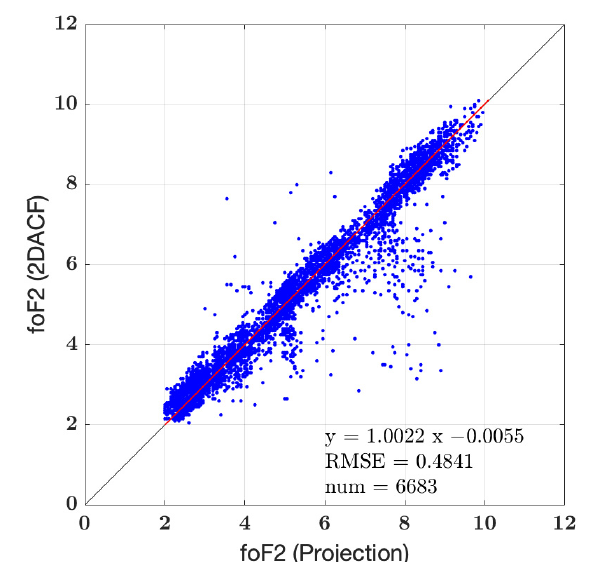
Figure 7. Scatter diagram of foF2 estimated from the 2-dimensional autocorrelation function (2DACF) versus the projection method.